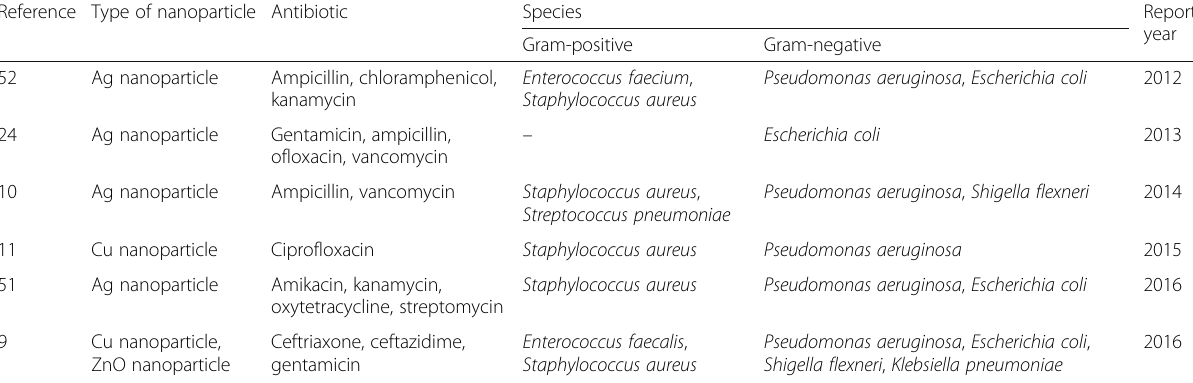
Table 1 Summary of the studies deducing synergy of nanoparticles and antibiotic as antimicrobial and anti-biofilm agent Reference Type of nanoparticle